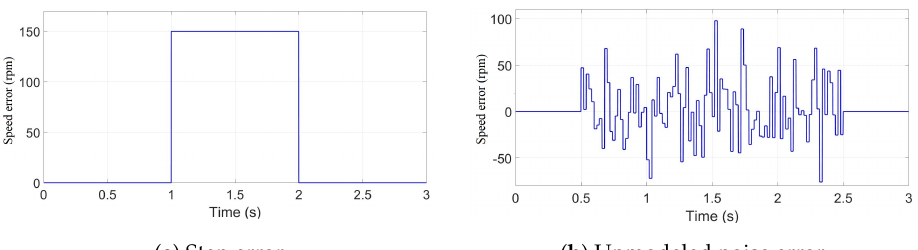
Figure 6. Failures of speed sensor.